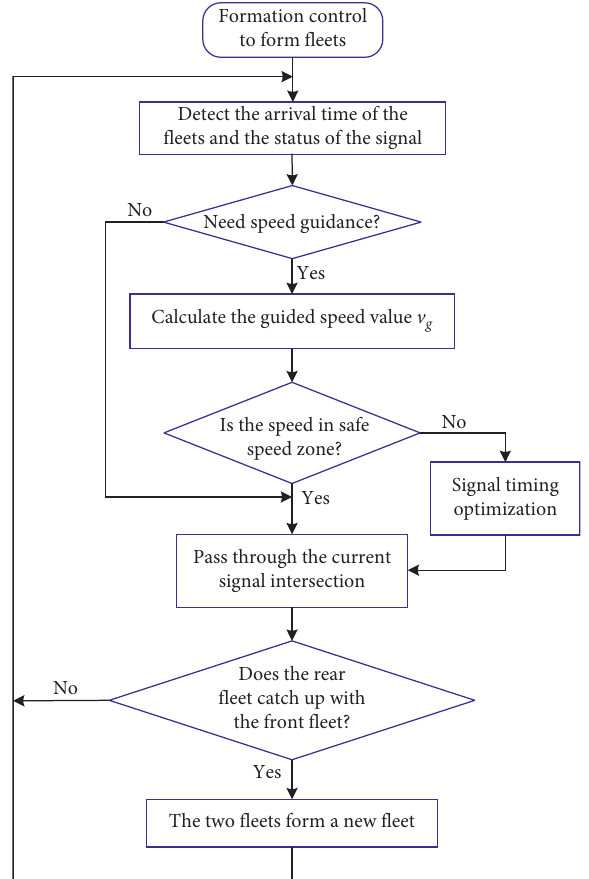
Figure 4: Control process of comprehensive optimization